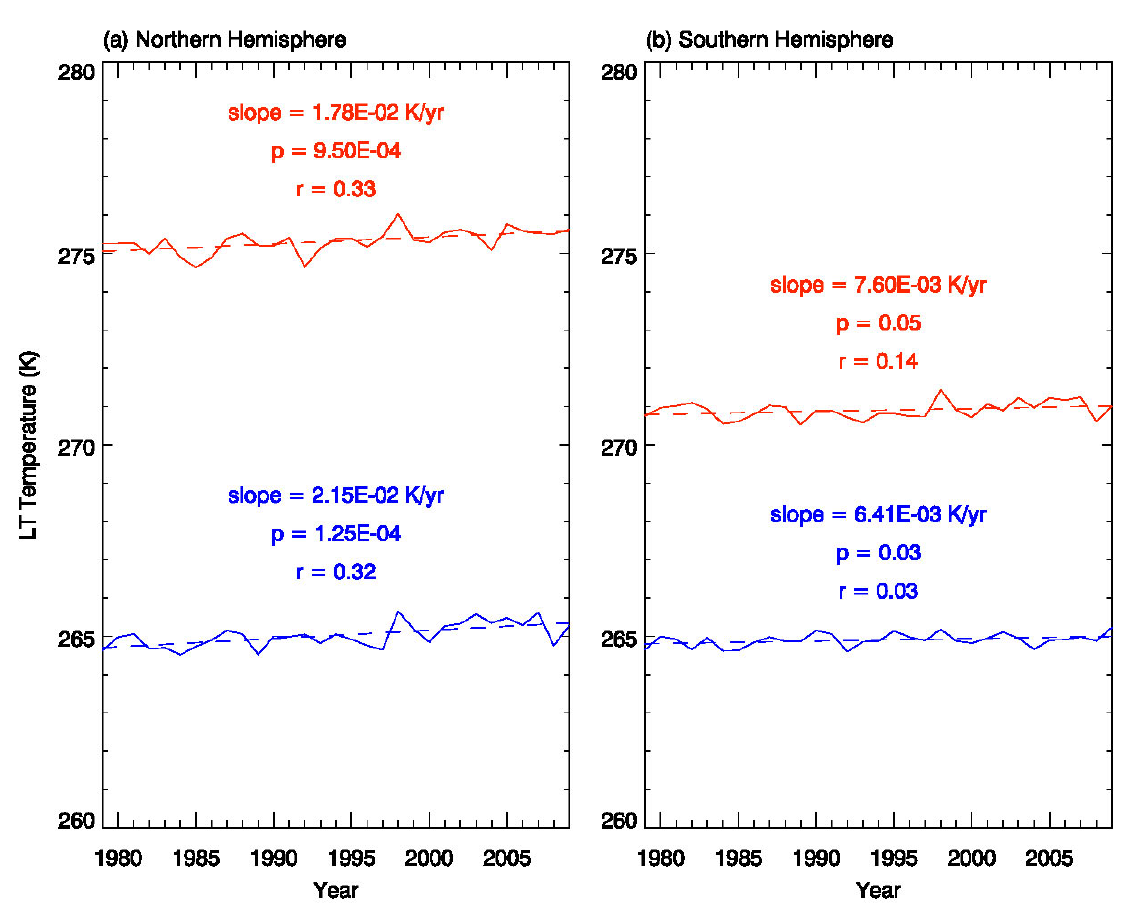
Figure 2. Same as Figure 1(b) but for the (a) Northern and (b) Southern Hemisphere separately. All regressions are significant at the 5% level. The autocorrelation coefficients (r) have a minimal effect on the values of